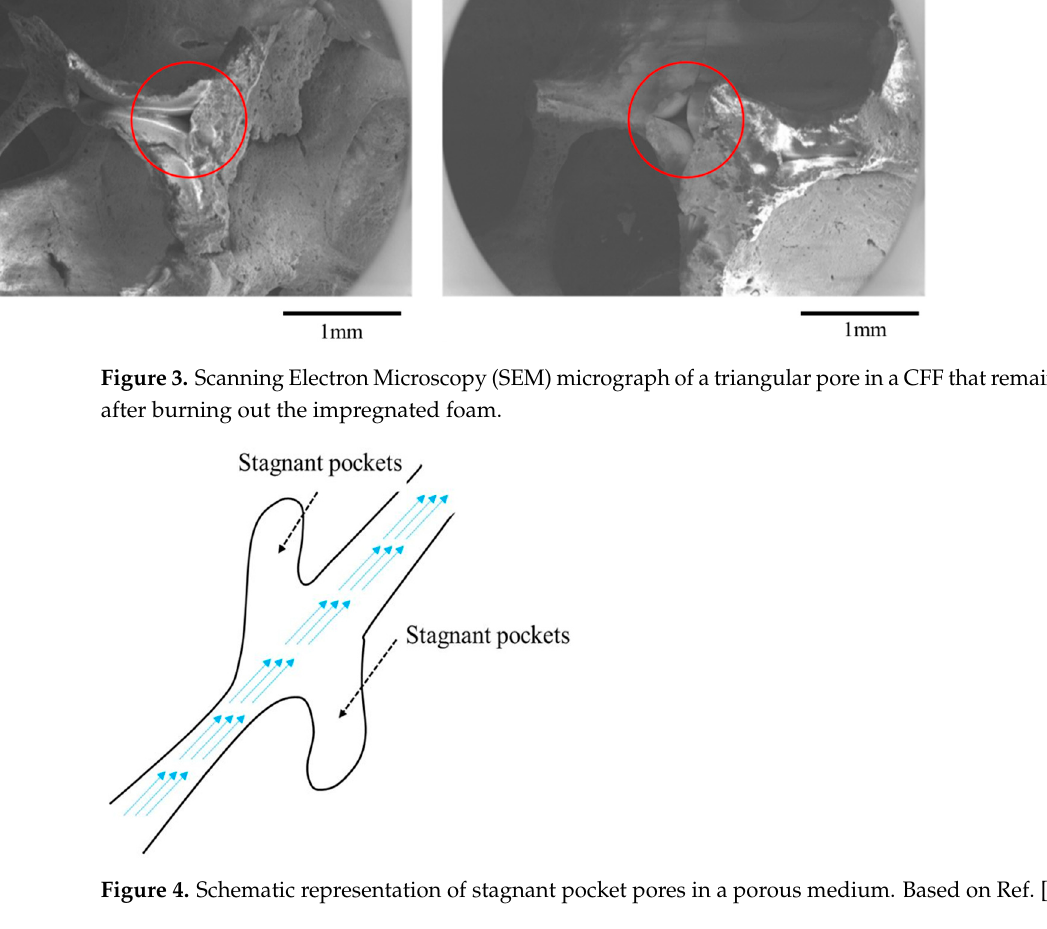
Figure 4. Schematic representation of stagnant pocket pores in a porous medium. Based on Ref. [17].